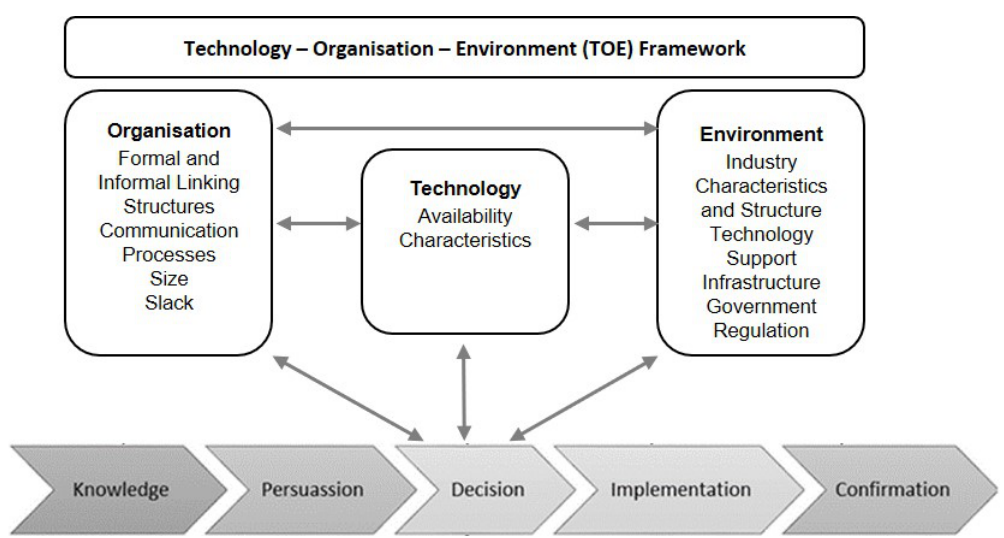
Figure 2. The TOE framework as originally defined by Tornatzky et al., (1990)